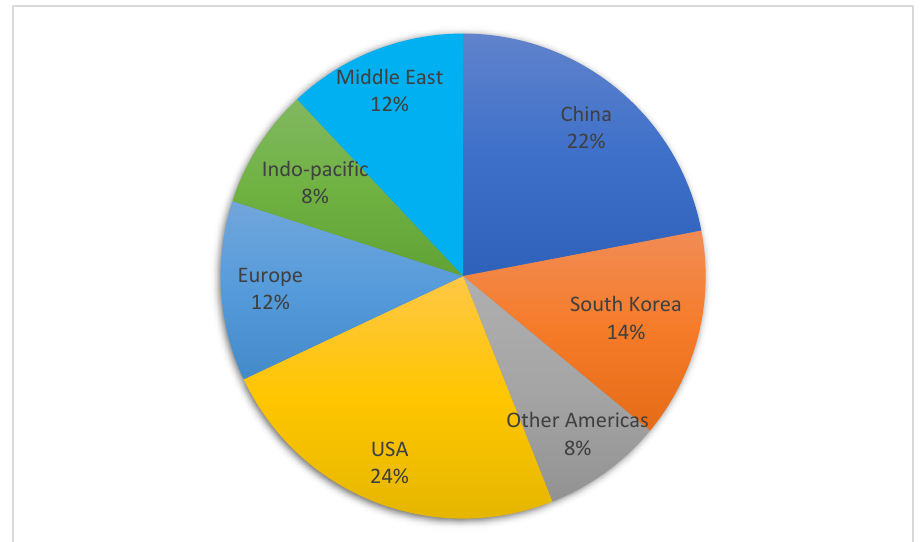
Figure 3. Location of research.